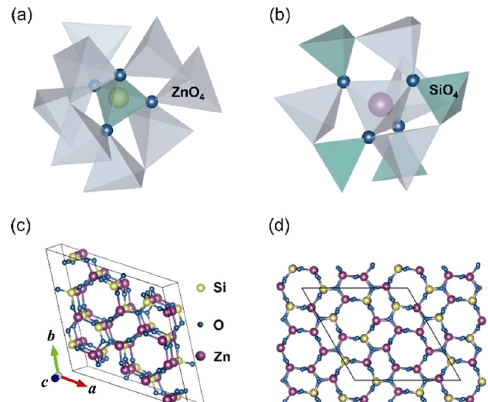
Fig. 1 Crystal structure of willemite Zn 2 SiO 4 . (a) One SiO 4 tetrahedron is corner-sharing with eight ZnO 4 tetrahedra, (b) one ZnO 4 tetrahedra is corner-sharing with four ZnO 4 tetrahedra and four SiO 4 tetrahedron, (c) corner-sharing tetrahedra of ZnO 4 and SiO 4 form the three-dimensional (3D) framework, and (d) tunnel structure shows onto the ab